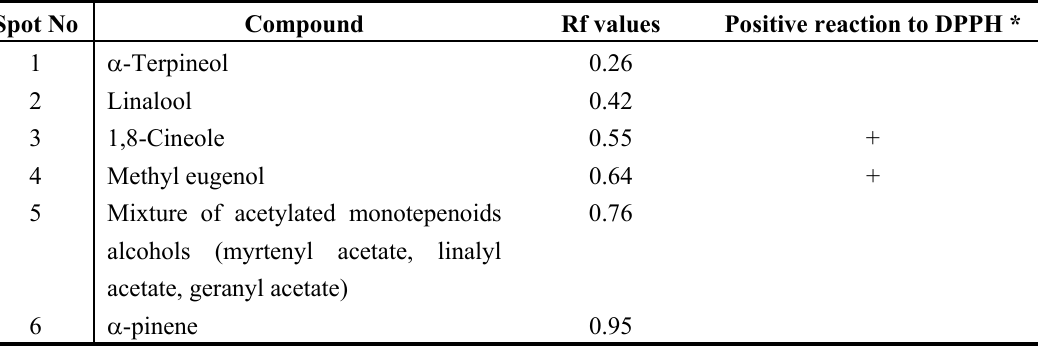
Table 3. DPPH Scavenging active compounds identified by the means of DPPH/ TLC (dot-blot)